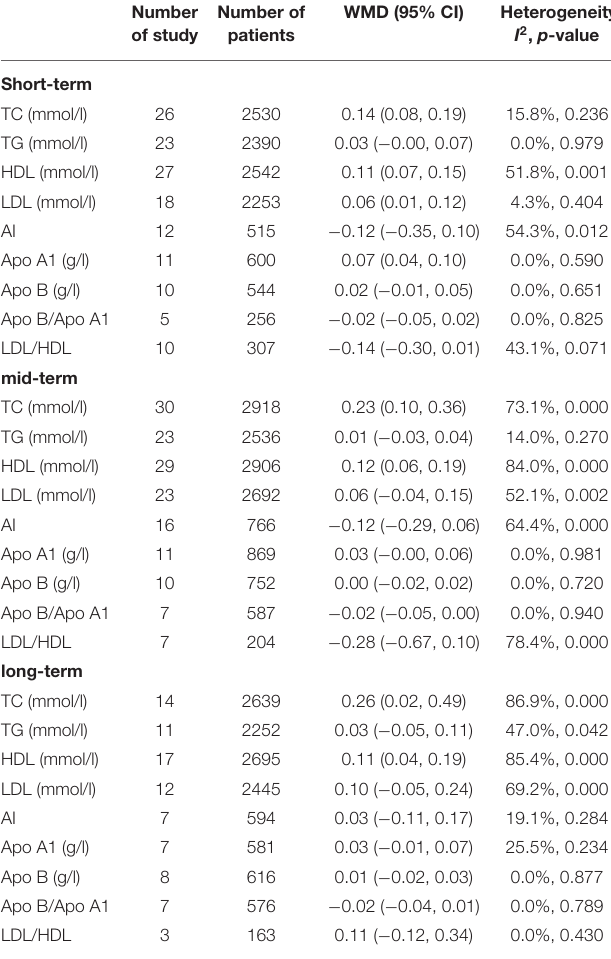
TABLE 2 | Summary of the meta-analyses of changes in lipid profile.